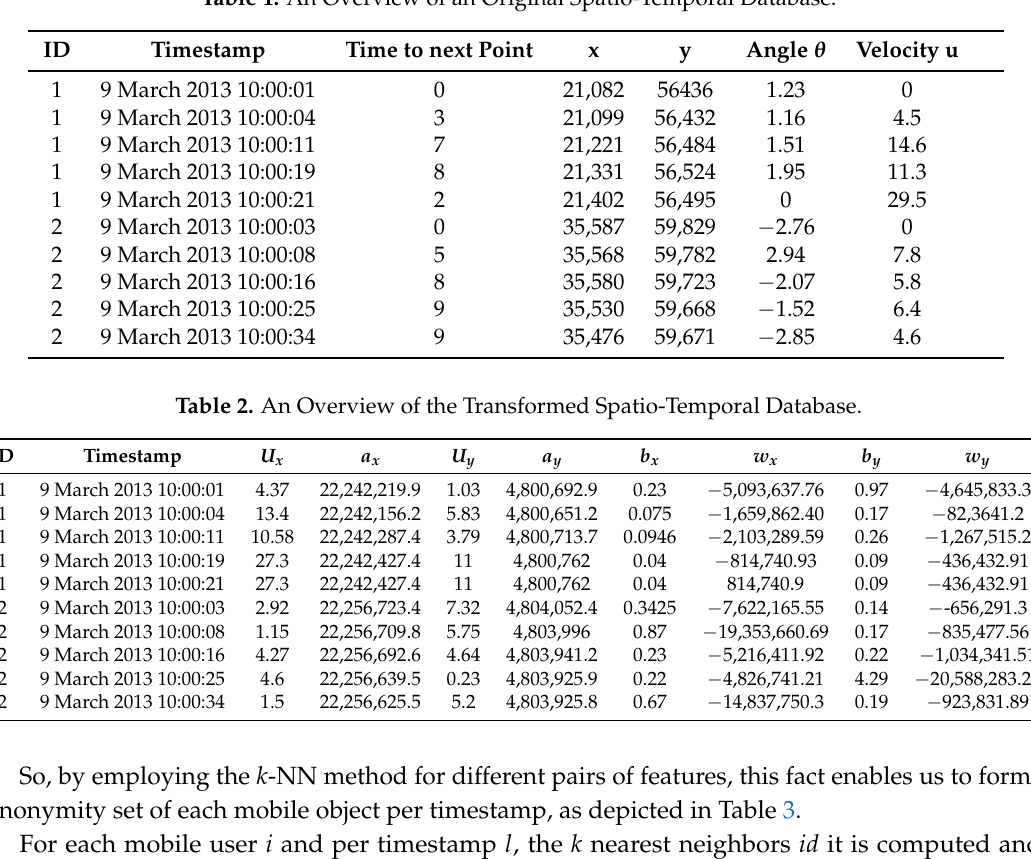
Table 1. An Overview of an Original Spatio-Temporal Database.